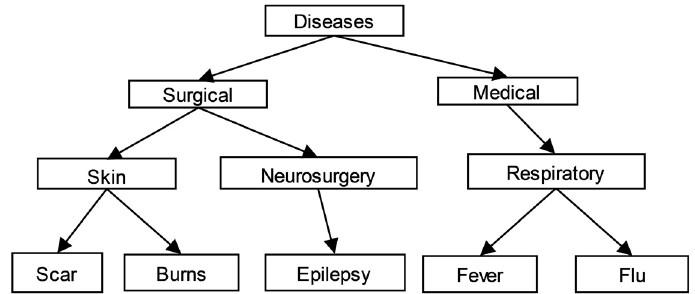
Figure 1. Attribute hierarchy generalization structure of disease Figure 1. A tt ribute hierarchy generalization structure of disease a tt ribute.